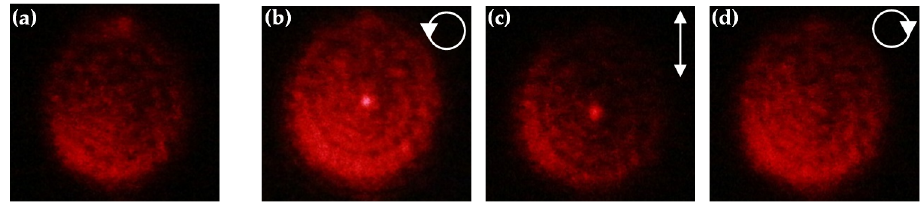
Figure 5. The optical images of the sample on the focal plane observed by using a camera: ( a ) at the initial state; the sample is irradiated by the pumping intensity of 20 mW/cm 2 for 15 min and detected by ( b ) left-handed circular polarization (LCP); ( c ) linear polarization (LP); and ( d ) right-handed circular polarization (RCP) of the probe beam. The white arrows indicate the polarization state of the probe beam.